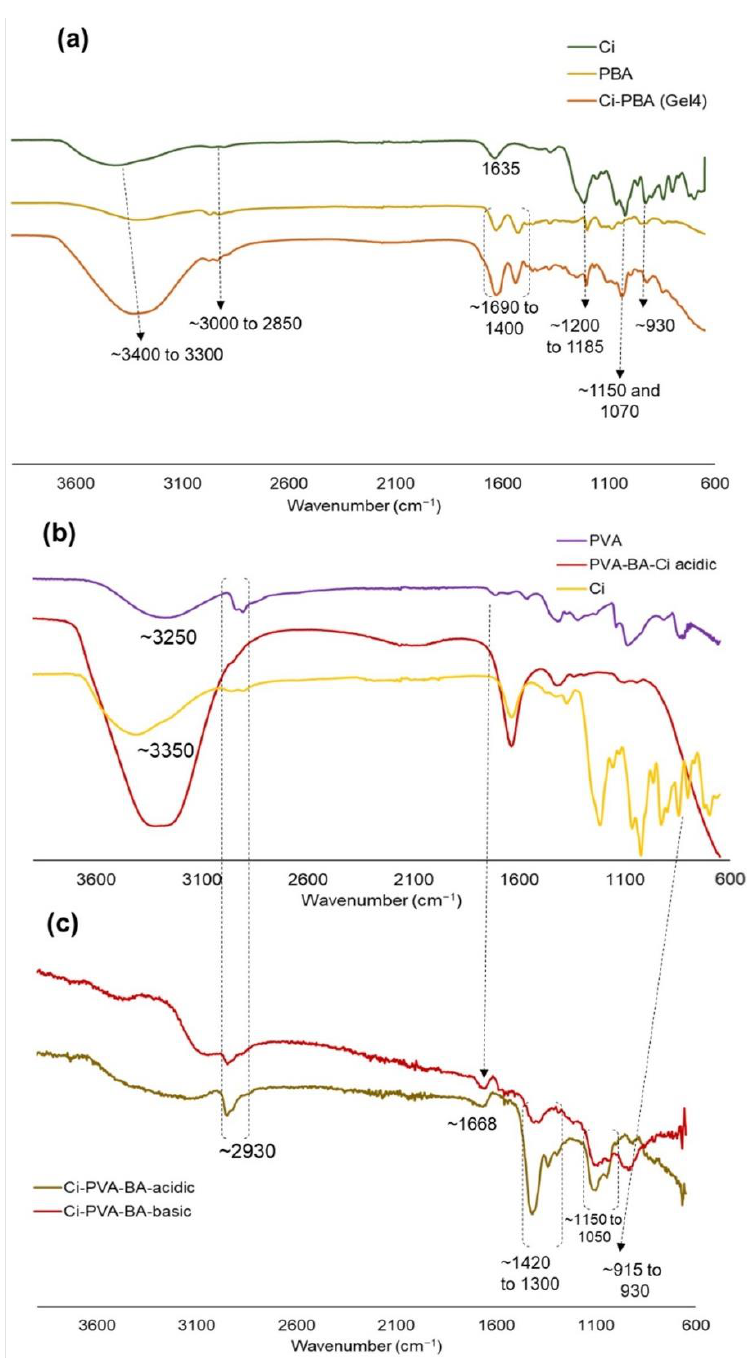
Figure 8. FTIR spectra of: ( a ) C i -PBA Gel 4 and the native PBA and C i polymers, and ( b ) C i -PVA-BA (Gel 7P) and native PVA and C i polymers. ( c ) FTIR spectra of Gel 7P with subtracting the aqueous buffer peaks before and after the pH adjustments from acidic to basic conditions. The x-axis and y-axis represent percentage (%) transmittance and wavenumber (cm −1 ), respectively.